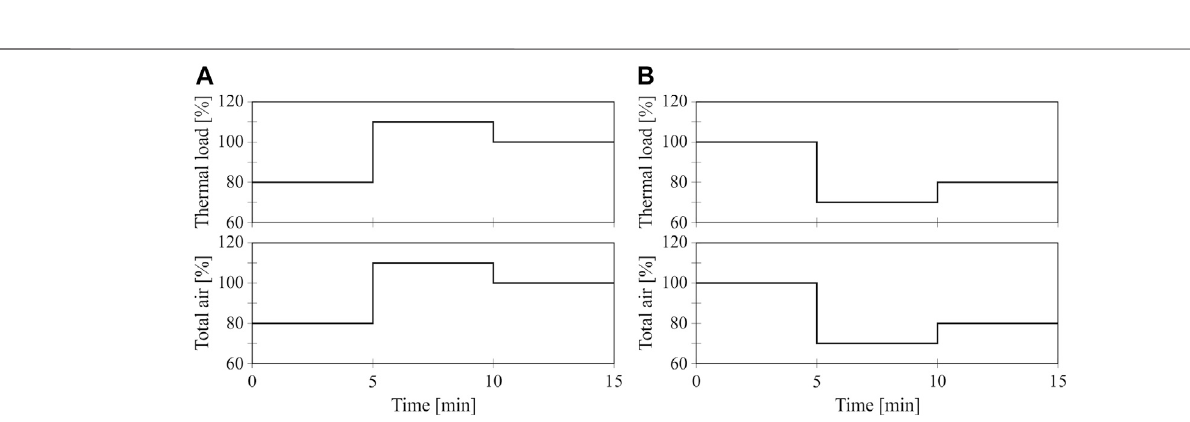
FIGURE 13 | Concept of elevated load steps. (A) Load increase (B) Load